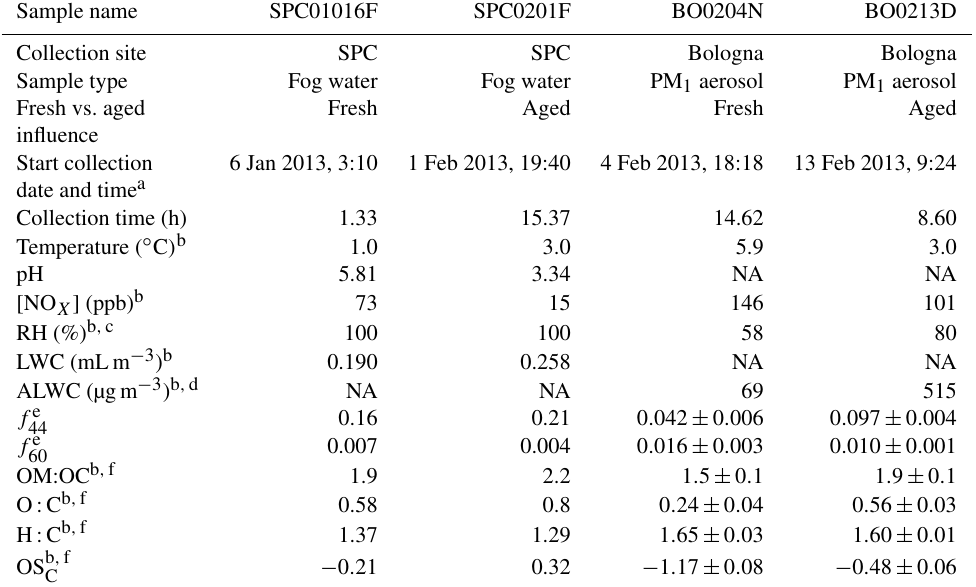
Table 1. Sample collection, identification and HR-ToF-AMS data. Relative humidity (RH), liquid water content (LWC), and aerosol liquid water content (ALWC) are averaged over the sample collection time. Fog samples were collected at San Pietro Capofiume (SPC). Fog water samples were re-aerosolized for HR-ToF-AMS data analysis, while aerosol sample data are from online measurements. For aerosol samples, the standard deviation of online measurements corresponding to the sample collection period is